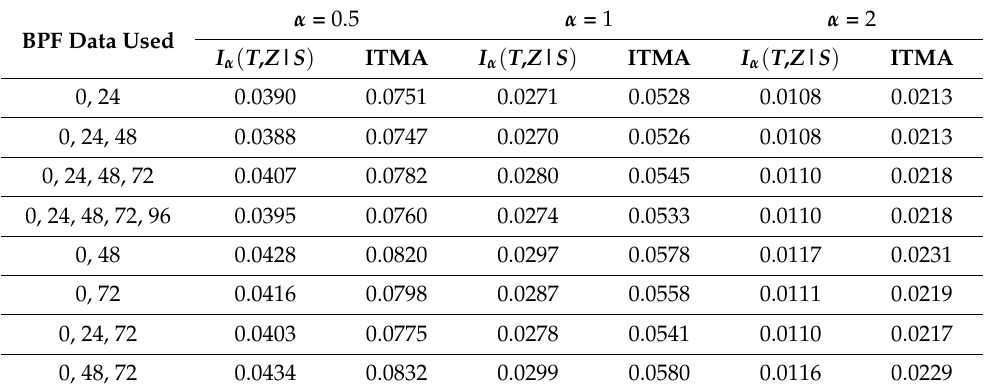
Table 3. Prentice Criteria for Surrogate Endpoint (see Appendix A.3). BPF Data